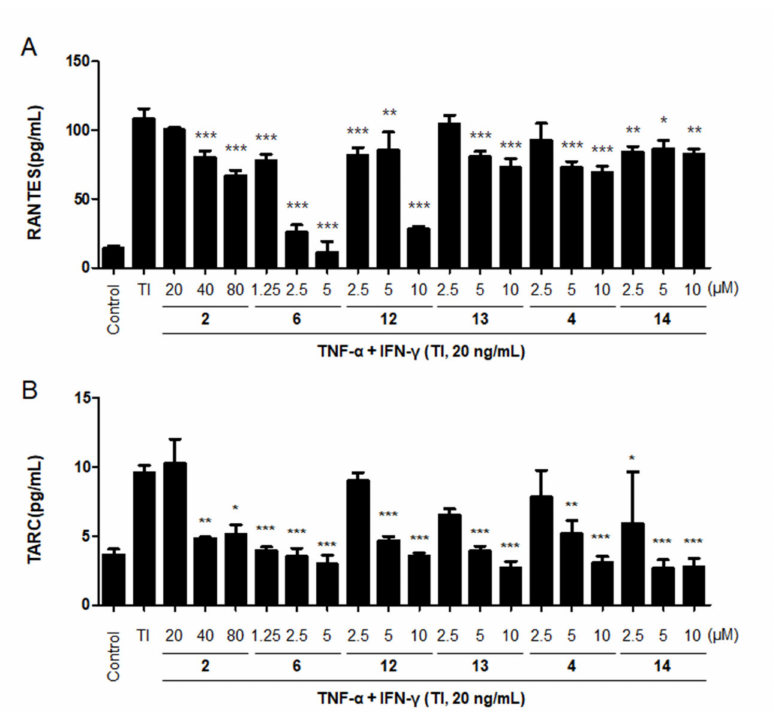
Figure 3. Effects of the six compounds from C. tricuspidata on RANTES ( A ) and TARC ( B ) production in TNF- α + IFN- γ -treated HaCaT cells. HaCaT cells were incubated with TNF- α + IFN- γ (20 ng/mL) in the presence or absence of the six compounds at the indicated concentrations. After 24 h, the chemokine secretion levels were analyzed using enzyme-linked immunosorbent assay (ELISA). Data are presented as the mean ± standard deviation. * p < 0.05, ** p < 0.01, and *** p < 0.001 compared with TNF- α + IFN- γ only. TI: TNF- α + IFN- γ